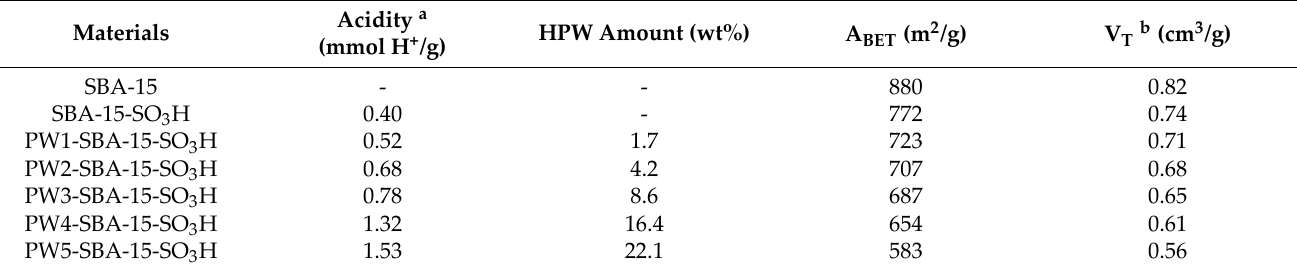
Table 1. Characterization of the materials.